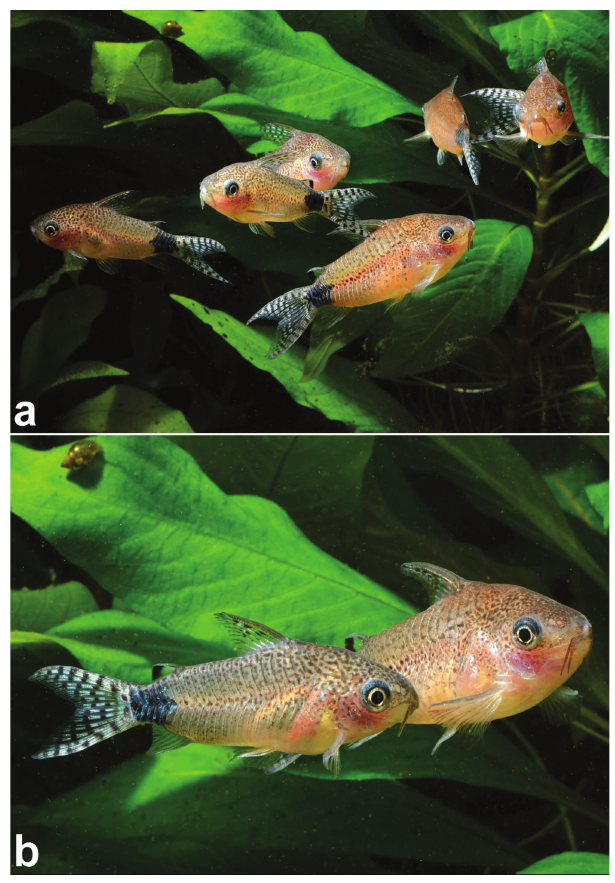
Fig. 5. Live uncatalogued specimens of Corydoras guapore in aquarium displaying their general color pattern. Also showing (a) a small breeding group of six specimens freely swimming in the midwater; and (b) a pair, the male on the left (between 20.0-30.0 mm SL), and the female on the right (approximately 40.0 mm SL). Photos by Hans-Georg Evers.